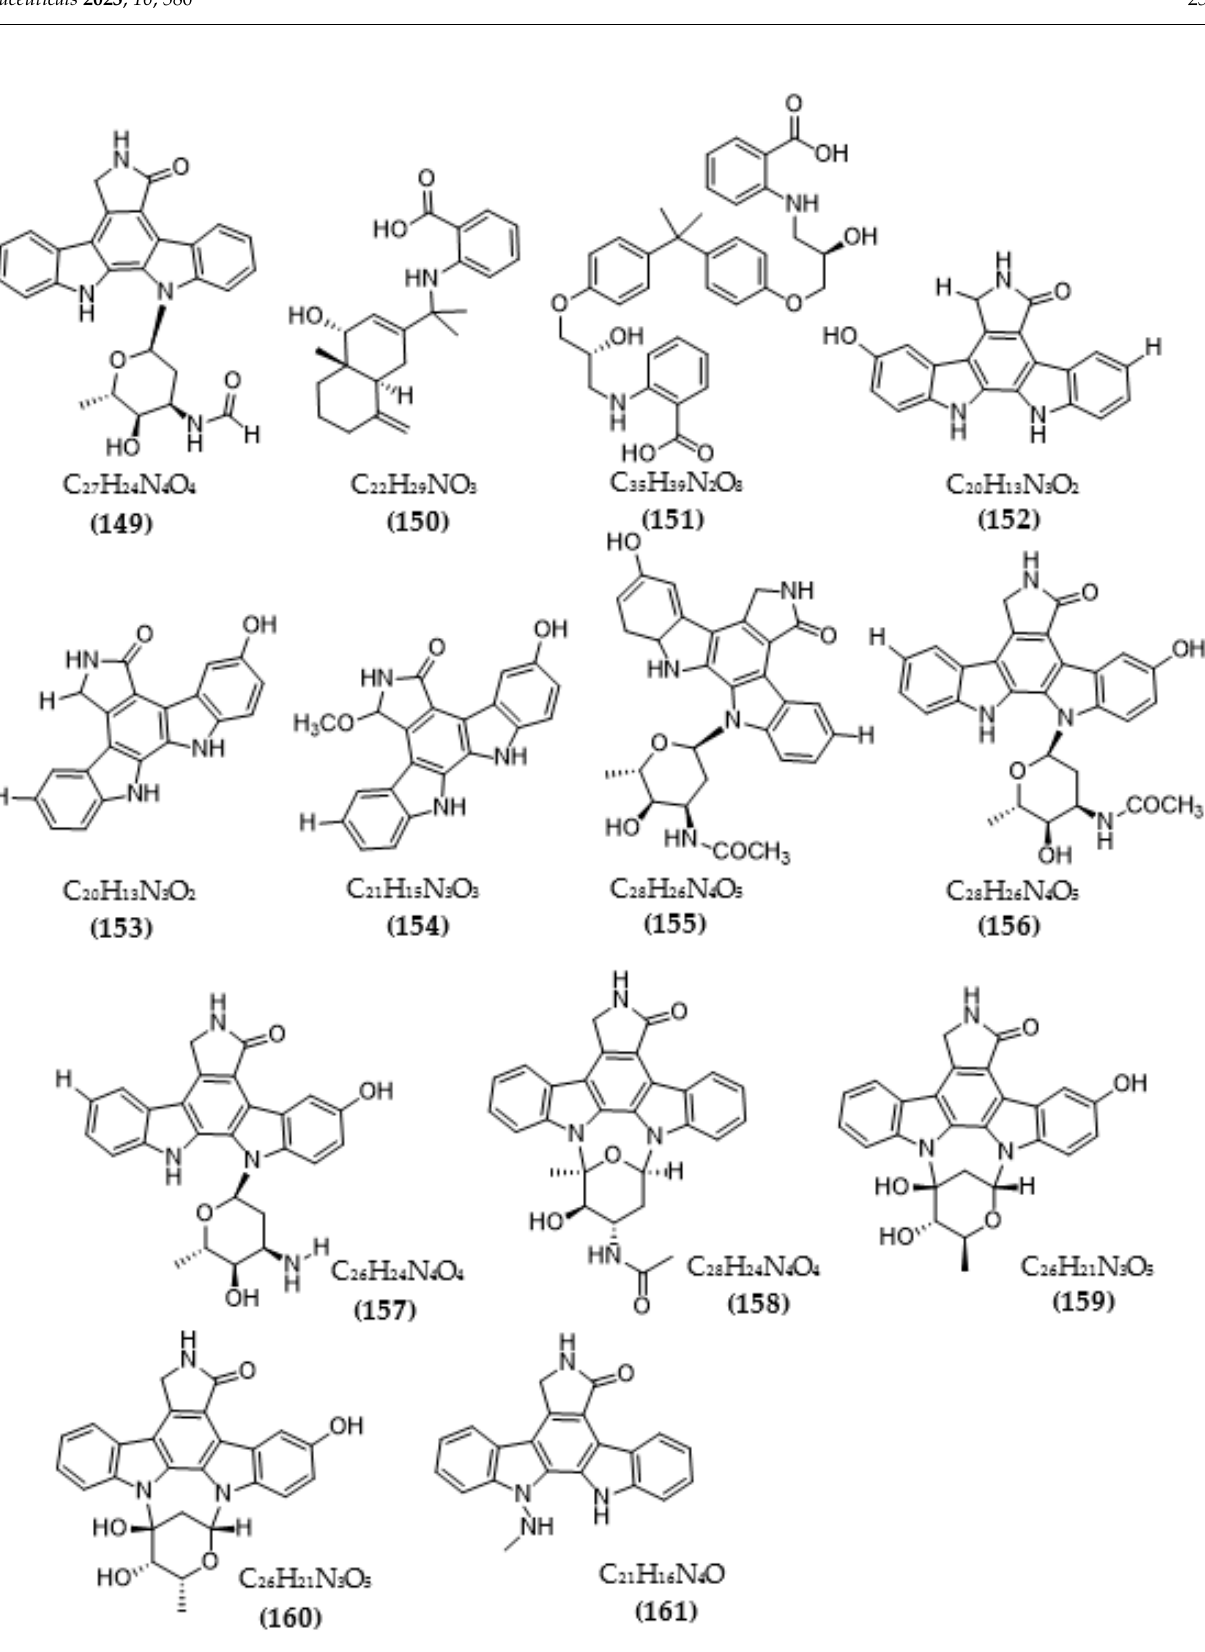
Figure 4. The chemical structures and chemical formula of inhibitors for other enzyme targets in AD from microorganisms.